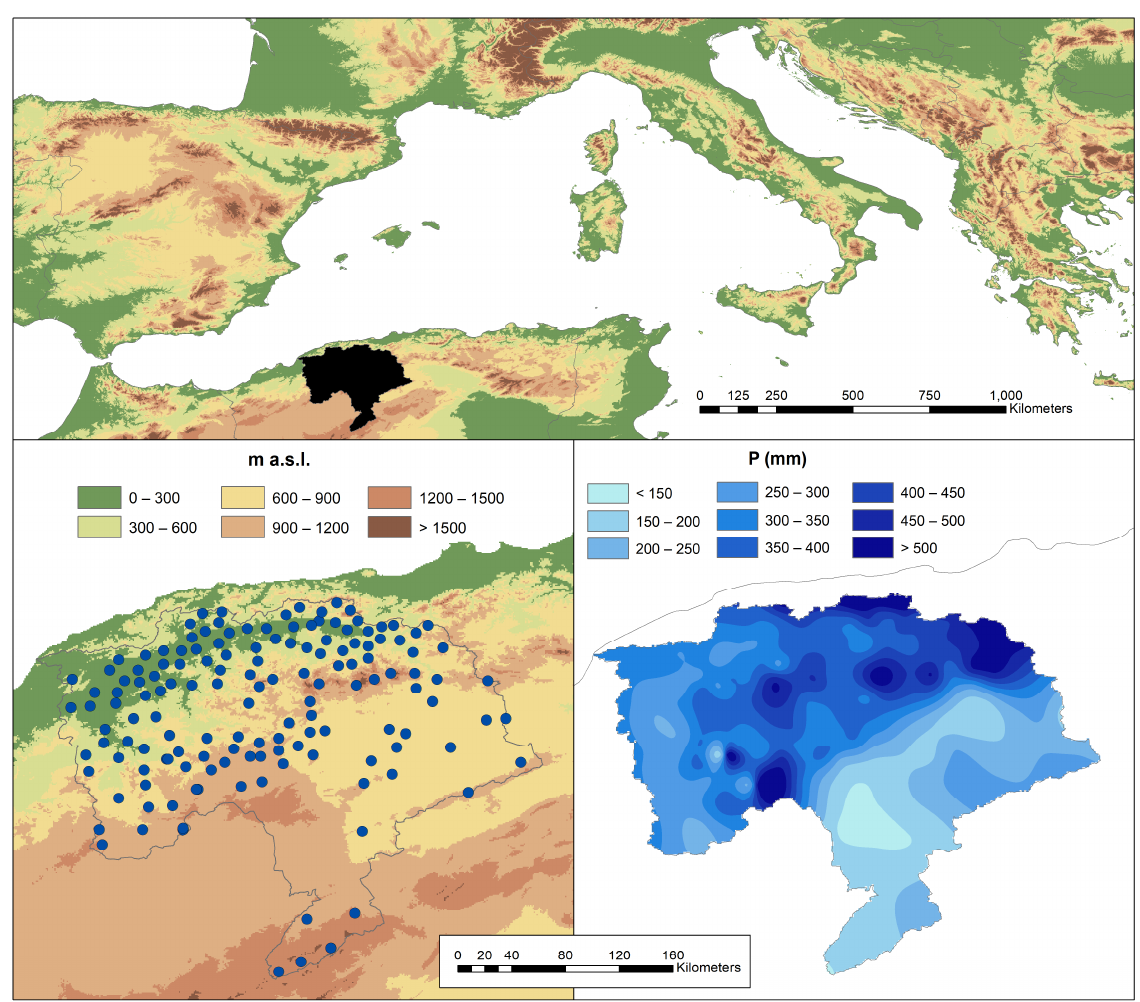
Figure 1. Location of the study area and of the selected 150 rain gauges on an elevation map, along with the distribution of the average annual precipitation evaluated from the 150 rain gauges with a spline interpolation.